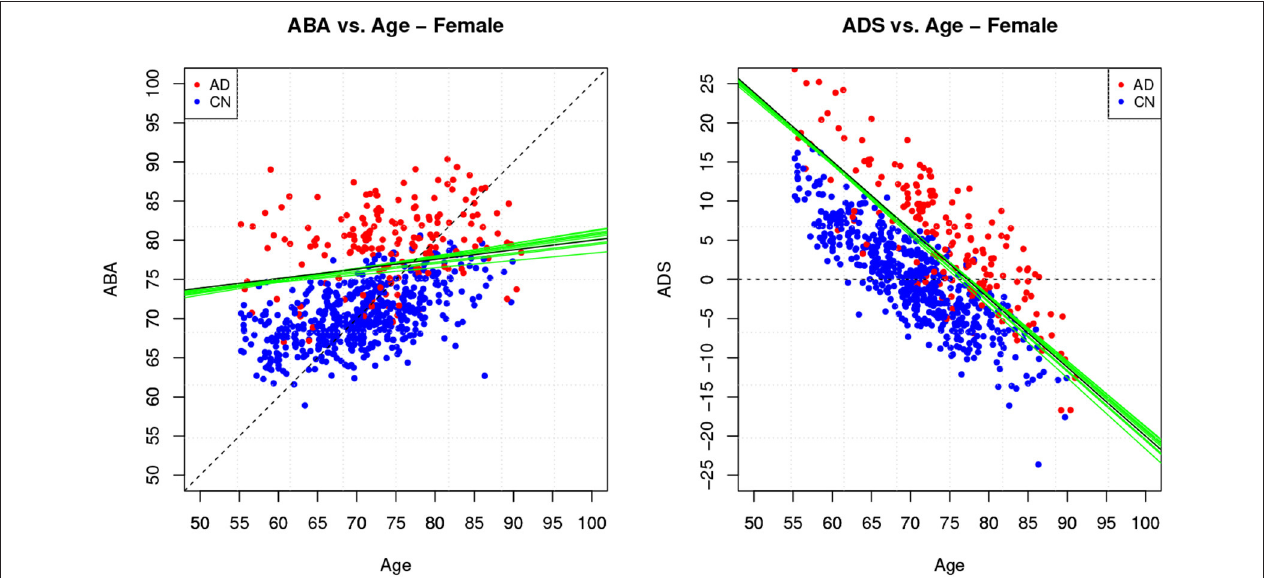
FIGURE 4 | Method M6: Apparent Brain Age vs. chronological age for the female gender group. The plot on the left shows ABA vs. age; the plot on the right shows the ADS vs. age for the same data and with the equivalent boundary line. The ABA values are generated as test set predictions from the folds of a single cross-validation execution. The solid black line is the logistic regression decision boundary of the final model; the green lines are the boundaries in the individual folds of cross-validation; the dashed line is included as reference. The black boundary line is indicative and is obtained from the single final model trained on all